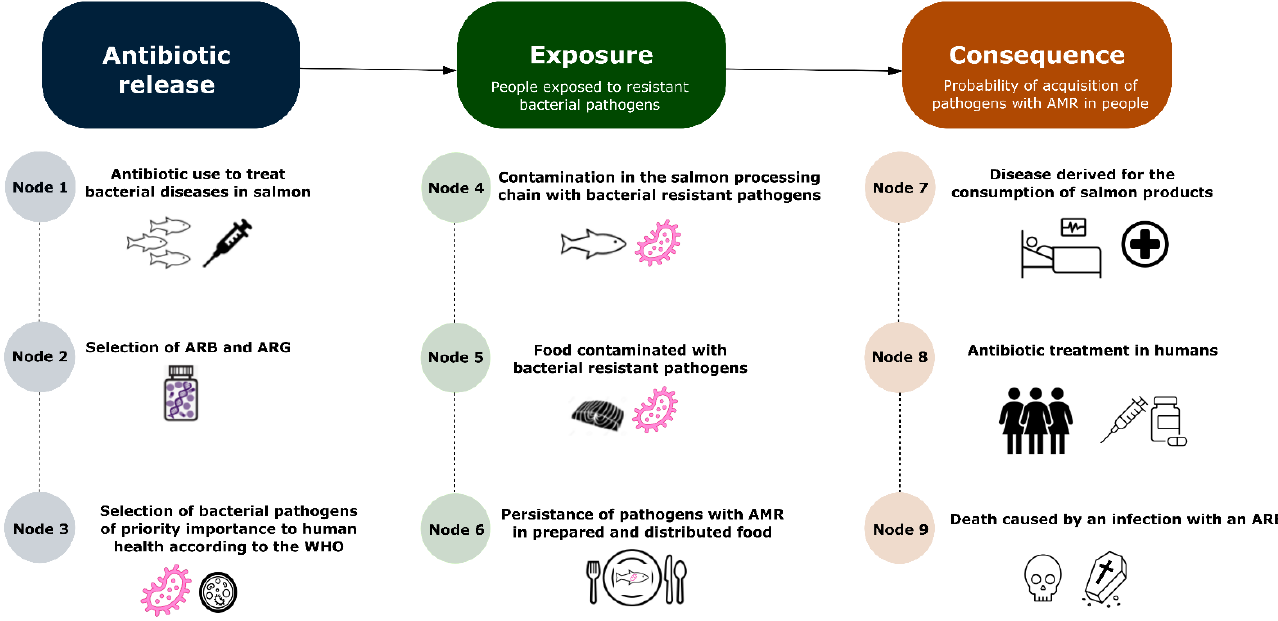
Figure 1. Risk nodes (event under analysis) for emergence and spread of antimicrobial resistance (AMR) among humans through consumption of farmed salmon leading to serious consequences (e.g., death) identified by the experts that participated in the workshop “Brainstorming and expert workshop: Risk assessment for antimicrobial resistance from farmed salmon in Chile–A preliminary qualitative risk analysis” . ARB: antibiotic-resistant bacteria; ARG: antibiotic resistance gene; WHO: World Health